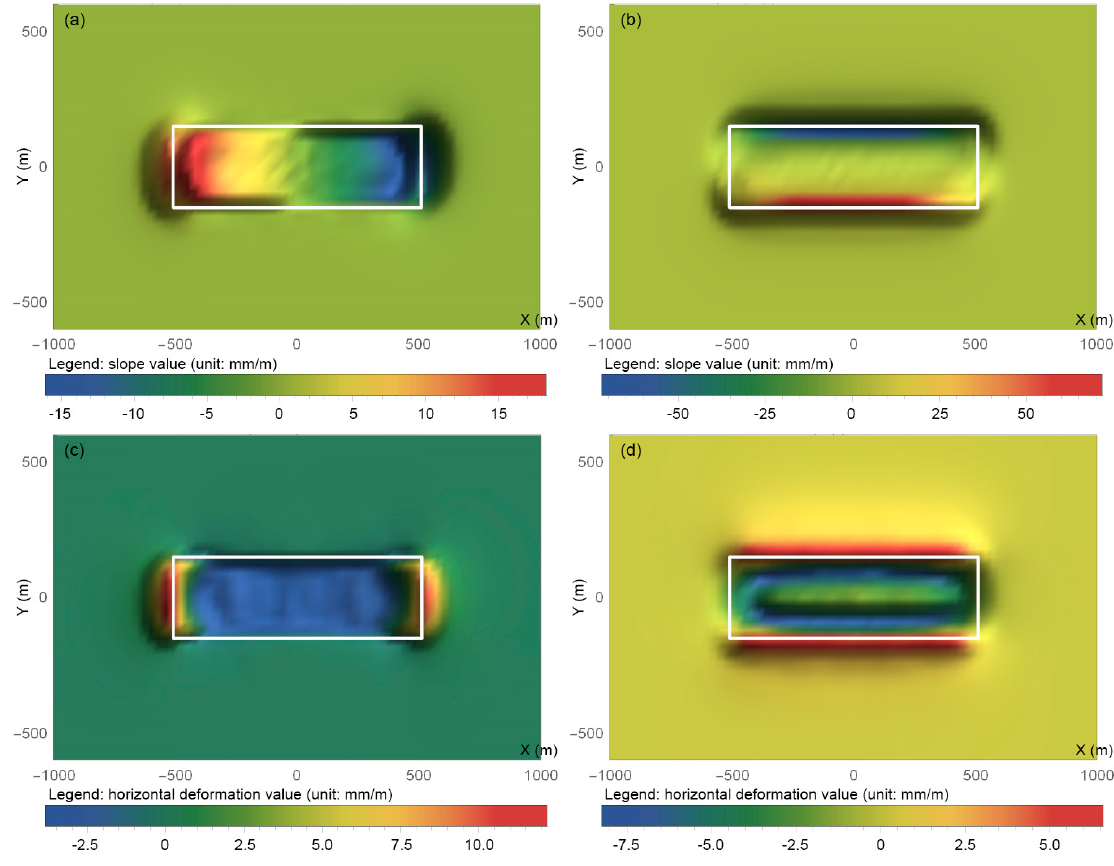
Figure 4. Slope and horizontal deformation for Test 5 (white rectangle is the undermined coalface): ( a ) slope in the strike direction of the coalface; ( b ) slope in the dip direction; ( c ) horizontal deformation in the strike direction; ( d ) horizontal deformation in the dip direction.